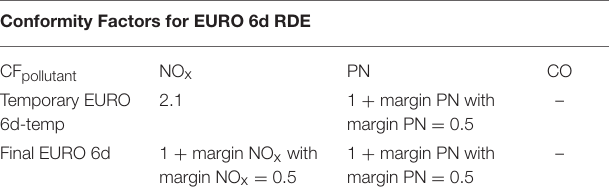
TABLE 2 | Conformity Factors for EURO 6d RDE (Commission,